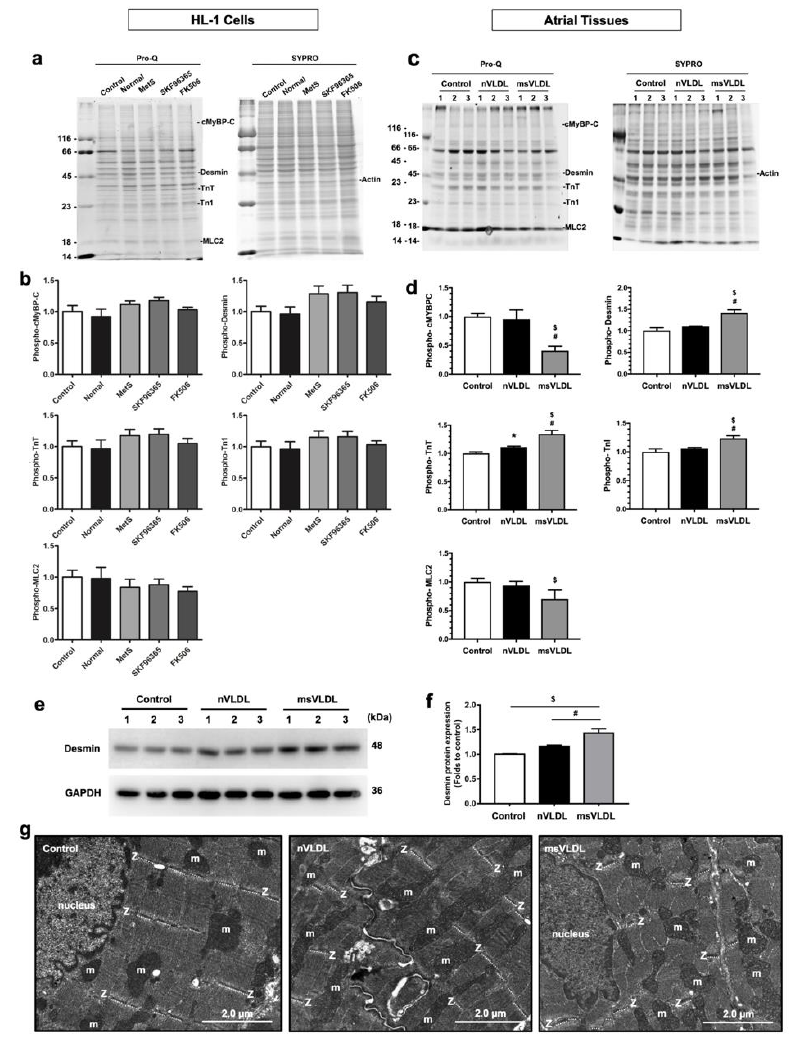
Figure 4. MetS-VLDLs altered myofilament protein expression and induced sarcomere derangement. ( a ) Phosphorylated cardiac myosin-binding protein C (cMyBPC), cardiac troponin I (TnI) and T (TnT), and myosin light chain 2 (MLC2) on 1D-gradient gels stained with ProQ Diamond reagent (left) and total protein expression shown on the gel subsequently stained with SYPRO Ruby (right). SKF 96365, a STIM1-inhibtor; FK-506, a calcineurin-inhibitor; n = 4 for each group. ( b ). Densitometry analyses from gels with ProQ and SYPRO staining. ( c ) ProQ Diamond staining gels of mouse atrial proteins ( n = 3 for each group: Control; Normal-VLDL-injected mice, nVLDL; and MetS-VLDL-injected mice, msVLDL). ( d ) Densitometry analyses for phosphorylated cMyBPC, desmin, TnT, TnI, and MLC2. $ P < 0.05 msVLDL versus control; # P < 0.05 msVLDL versus nVLDL. ( e , f ) Western blot and densitometry analysis for desmin in atrial tissues. ( g ) Representative transmission electron microscopy (TEM) pictures (at 5000 × magnification) showing disorganized Z lines (Z, highlighted with dashed lines) in the atrial tissue of mice receiving a MetS-VLDL injection (msVLDL) compared to normal Z lines in the controls and in mice receiving normal-VLDLs (nVLDL) ( n = 3 for each group). Atrial sarcomeres are aligned with mitochondria